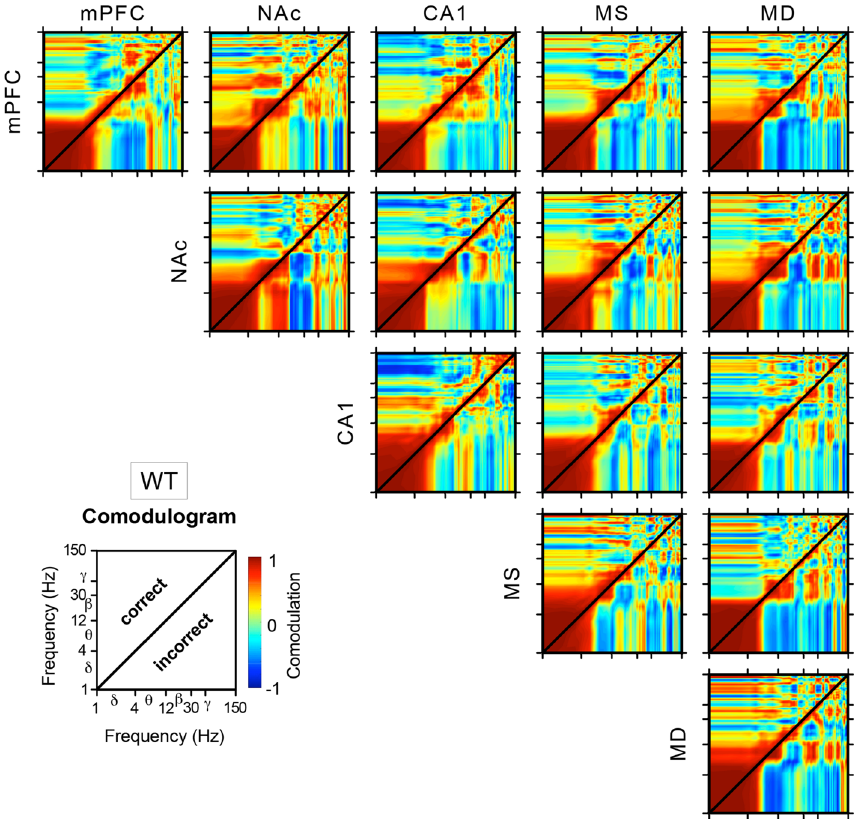
Figure 5. Power-power cross-frequency comodulagrams, in log 10 − log 10 scale, of WT mice. Comodulogram (see Eq. 2 in “Materials and methods”) maps show coupling between pairs of LFP spectra collected from mPFC, NAc, CA1, MS and MD of WT mice after correct (upper triangular map) and incorrect (lower triangular map) outcome of the operant task. Notice that non-symmetric patterns indicate that correctness of the trial outcome influenced the cross-frequency